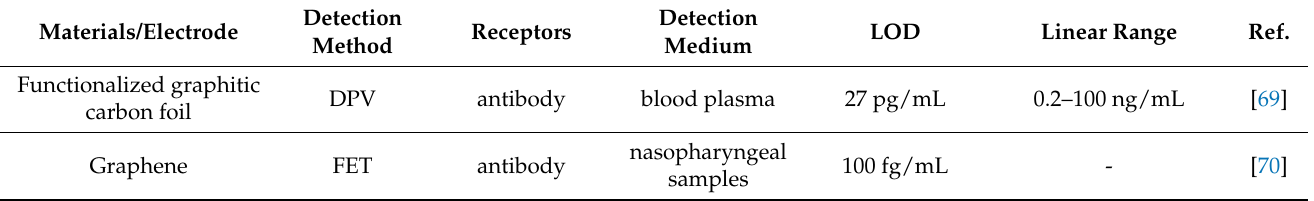
Table 3. Analytical performance of recently developed electrochemical biosensors for detecting SARS-CoV-2